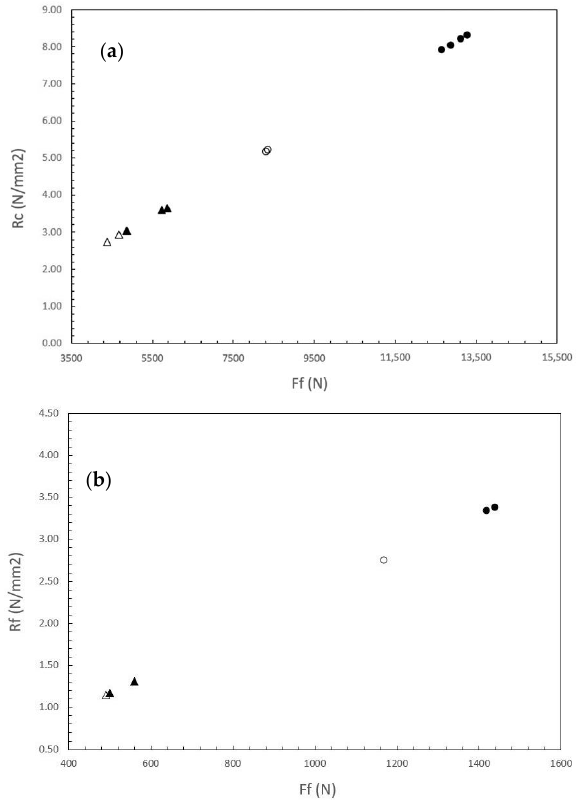
Figure 3. ( a ) Diagram reporting the uniaxial ( Rc ) and ( b ) flexural compressive ( Rf ) strengths at the fracture point for the standard and doped (ST with 5% of CFP) bentonitic grouts as a function of the load applied to the sample ( Ff and F c). Symbols are as follows: triangles for the standard grout; circles for the grout + 5% of CFP. Open symbols are for tests at 14 days, filled symbols for those at 28